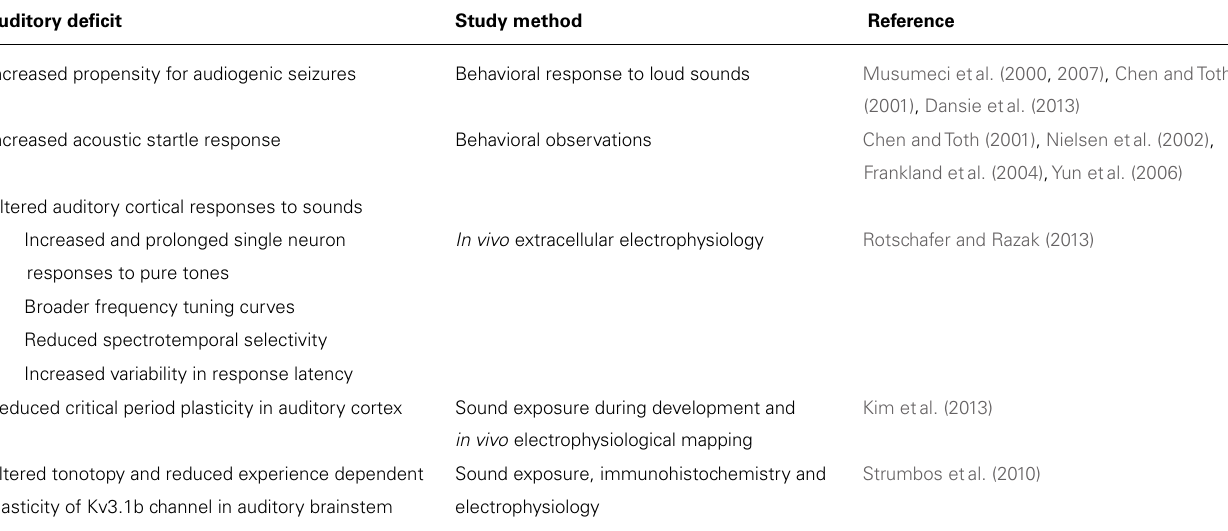
Table 2 | Summary of auditory processing abnormalities in the Fmr1 KO